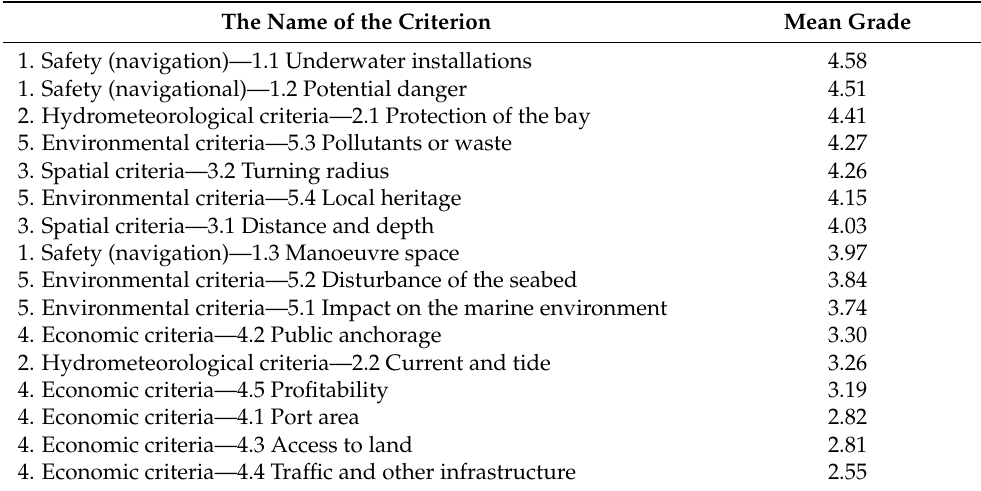
Figure 5. Excerpt from comparative results of both applied methods of multi-criteria decision making. Table 3. Survey result—sorted mean grades (from highest to